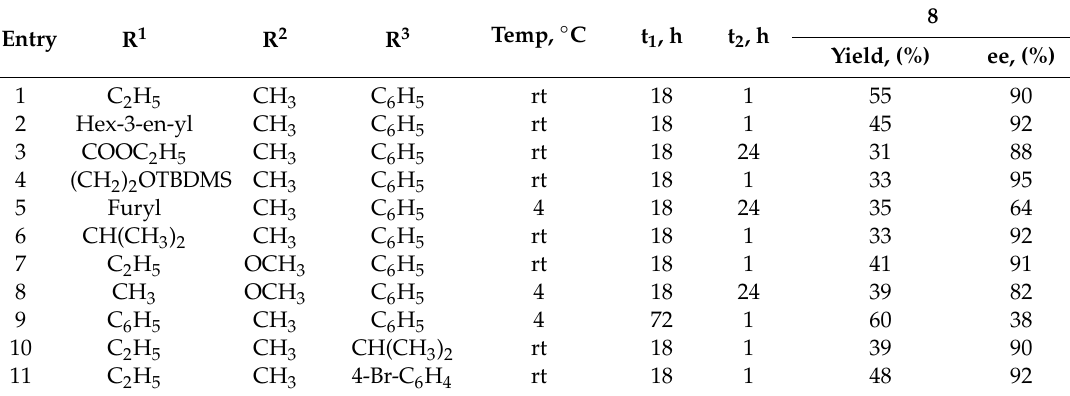
Table 4. Some characteristic examples of iminium catalysed 1,4-DHPs 8 synthesis [58].